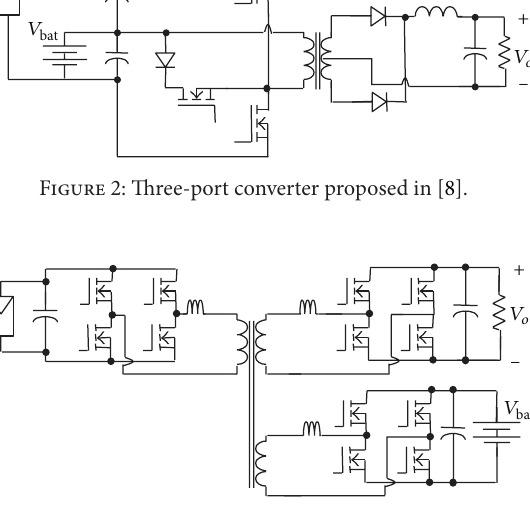
Figure 3: Three-port converter proposed in [9].